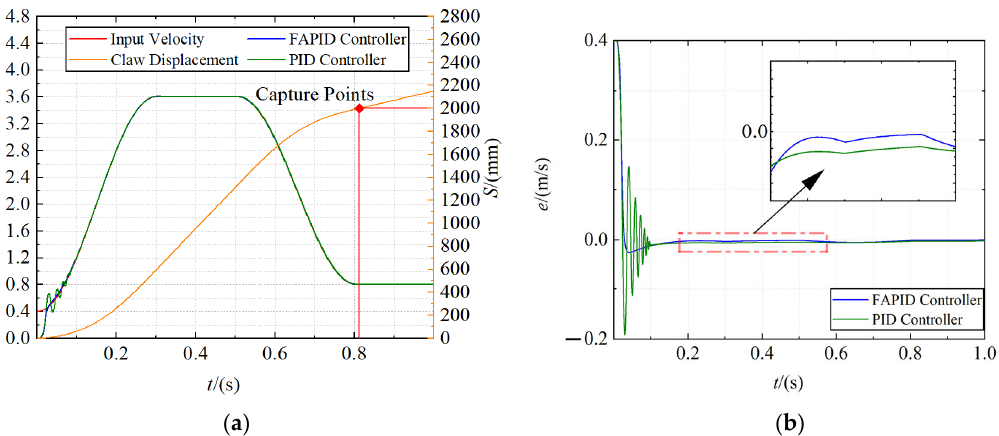
Figure 13. The capture curve of the far range (2000 mm). ( a ) The velocity curve and displacement curve; ( b ) the error curve.